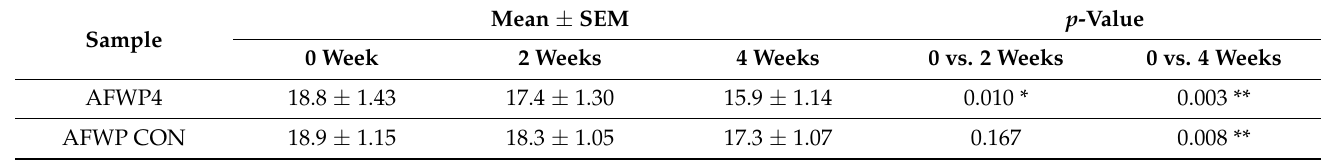
Table 4. Effects of AFWP4 on trans-epidermal moisture loss (TEWL).